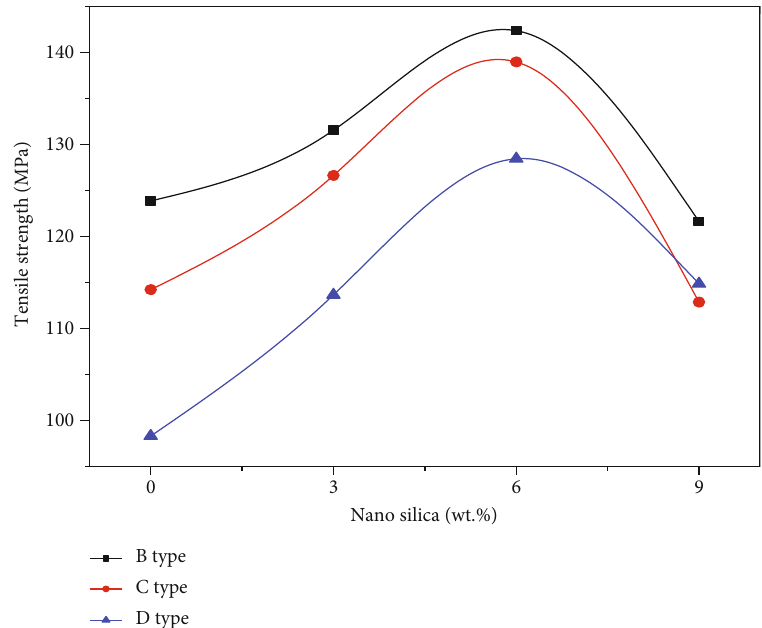
Figure 7: Tensile strength of nanocomposites based on the wt.% of